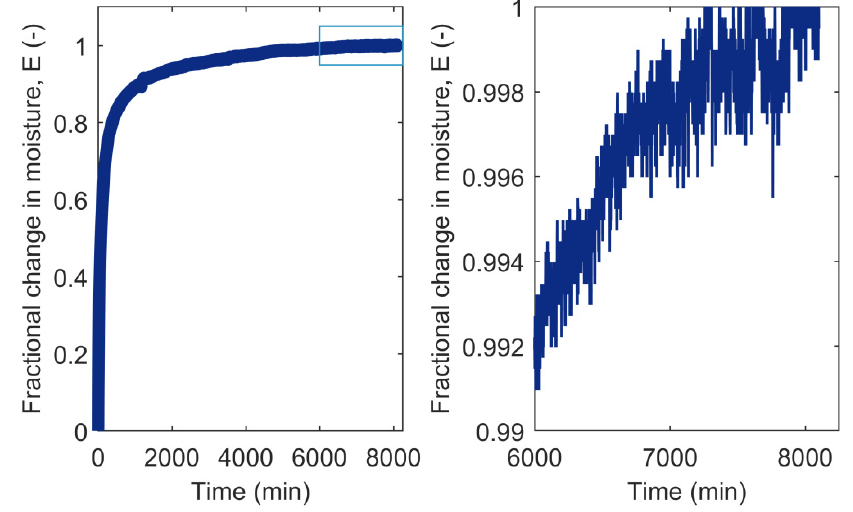
Figure 2. Fractional change in moisture content, E ( t ), calculated from the absorption data for loblolly pine ( Pinus taeda L.) from Figure 1. The rectangle in the left figure is expanded in the right figure.